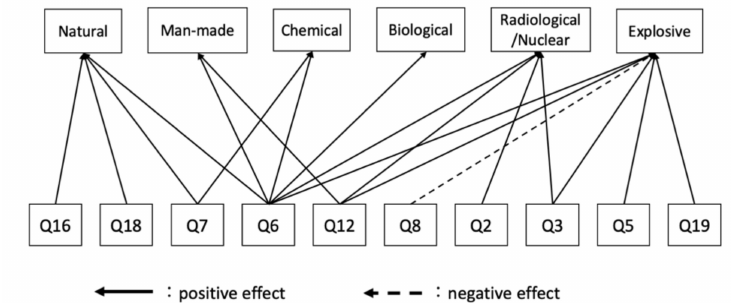
Figure 2. A path diagrammatic representation of the impact on intent to engage in each hazard based on survey questions. The solid and dashed lines represent a significant positive and negative impact on engagement intent score,